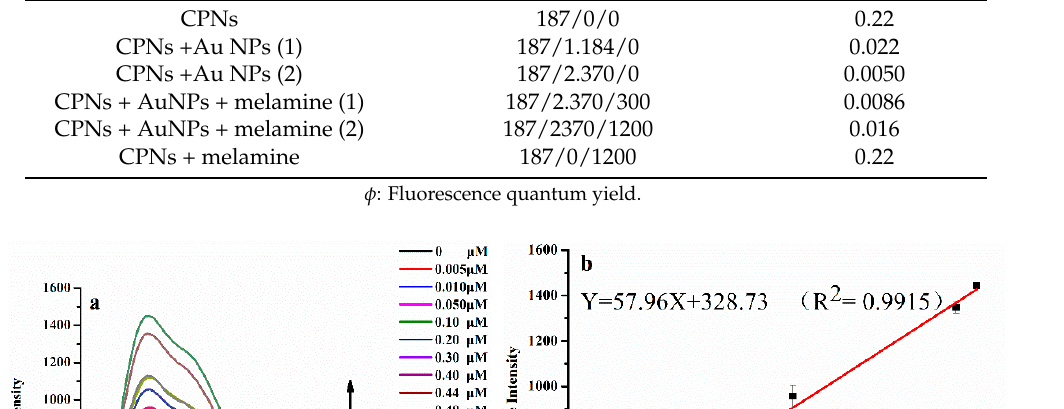
Table 2. The fluorescence quantum yields of CPNs under difference conditions.